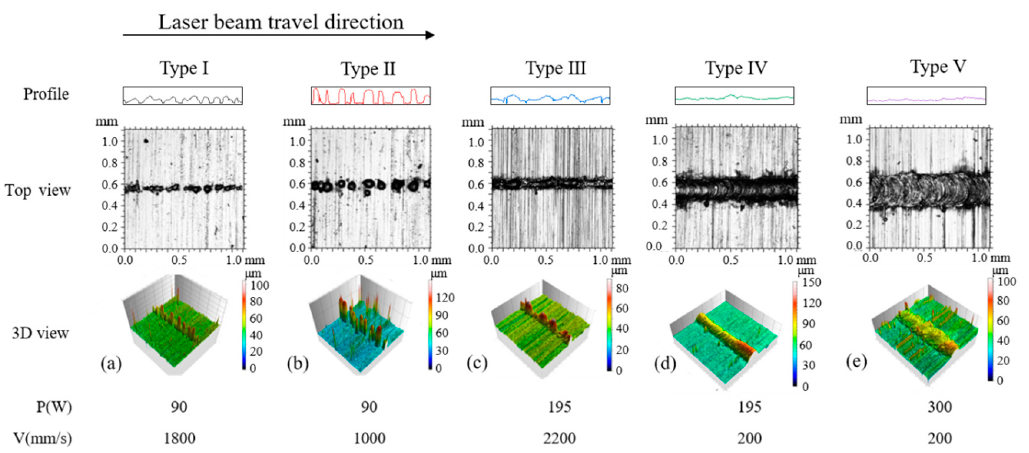
Figure 2. Examples of five types of SLM-fabricated single tracks. Laser power (P) and scan speed (V) were in the range of P = 90–300 W and V = 200–2200 mm/s. ( a ) Type Ⅰ : discontinuous and badly bonded to the substrate; ( b ) Type Ⅱ : discontinuous and made of “balls”; ( c ) Type Ⅲ : discontinuous and occasionally broken; (d) Type Ⅳ : bulged track with a fish-scale pattern; ( e ) Type Ⅴ : track with a fish-scale pattern and a flat top.